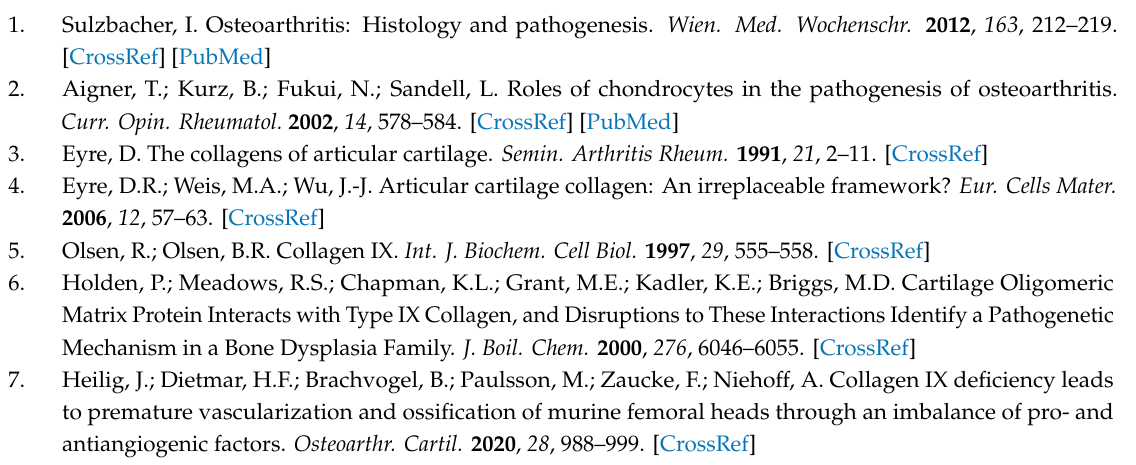
s1. Figure S1: Expression level of LSD1 in human articular chondrocytes from normal or OA cartilage. Figure S2: Expression level of LSD1 and SOX9 following dedi ff erentiation of human chondrocytes or their redi ff erentiation under hypoxic environment or 3D culture. Figure S3: Heatmap of the regulated genes following IL-1 β treatment of articular chondrocytes obtained from two di ff erent donors. Supplementary dataset 1: List of the regulated genes following LSD1 depletion in articular chondrocytes ( n = 3). Supplementary dataset 2: List of the regulated genes following IL-1 β treatment of articular